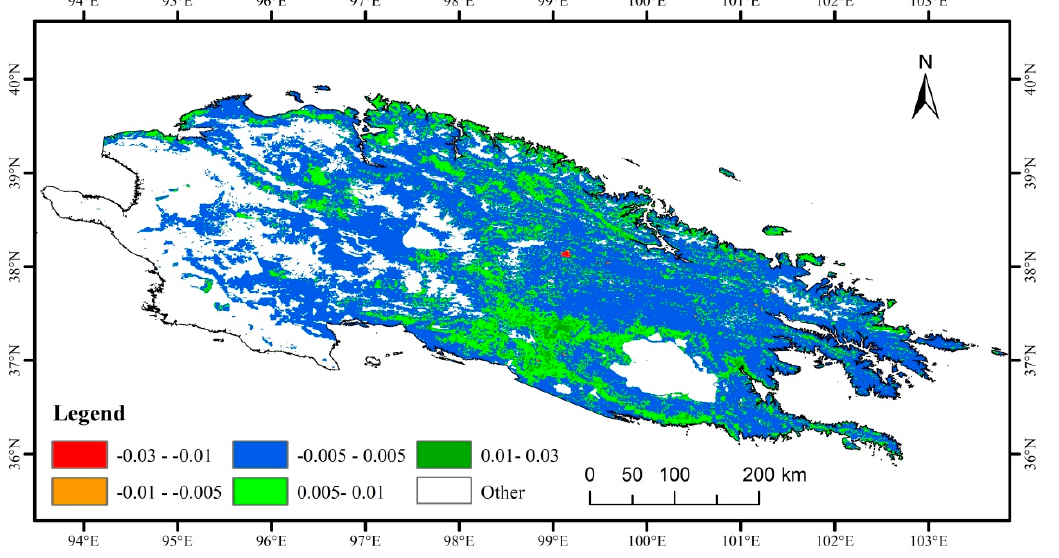
Figure 8. Spatial distribution of NDVI change trends from 2000 to 2017 based on the slope coefficient of the trend line.